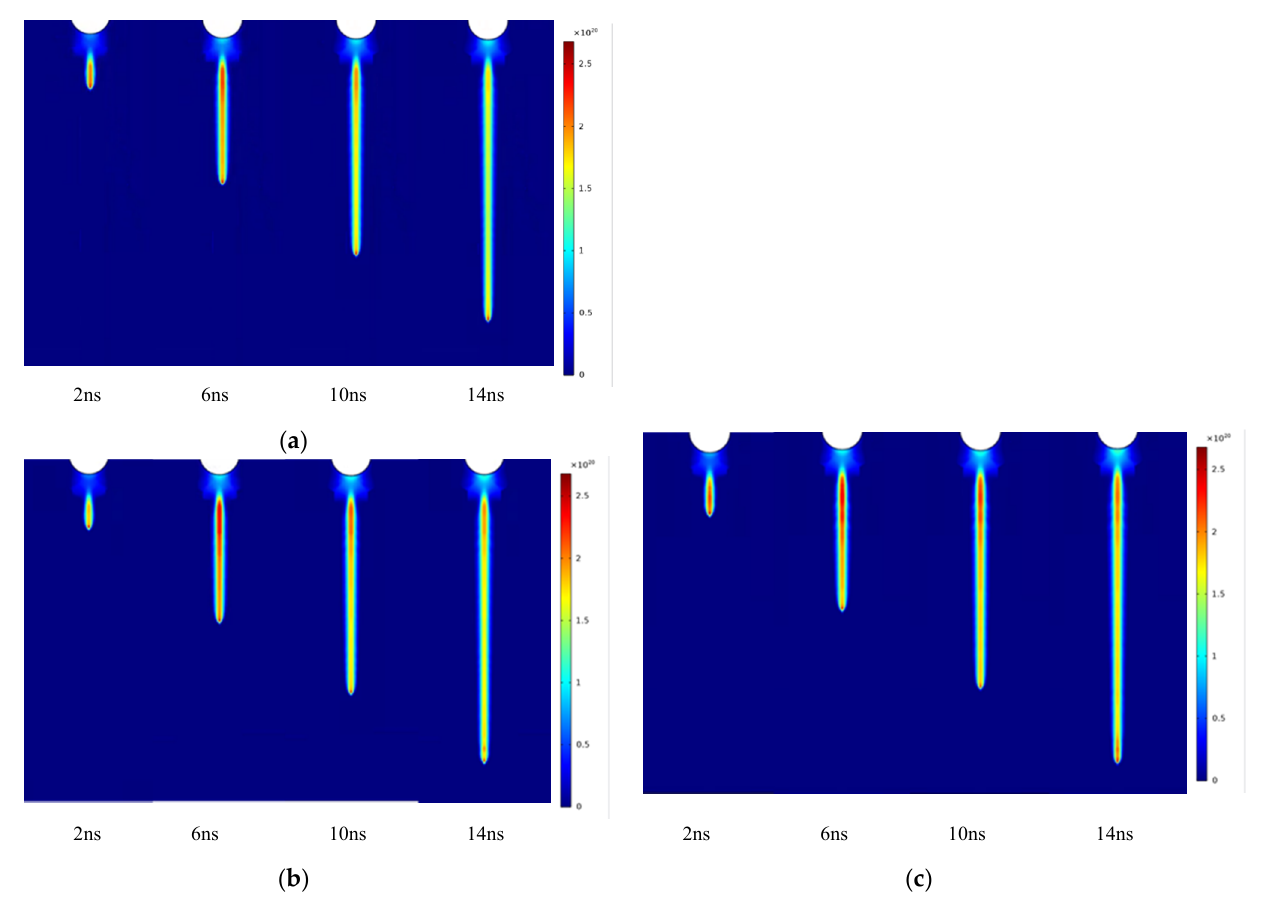
Figure 3. Two dimensional distribution of electron concentration: ( a